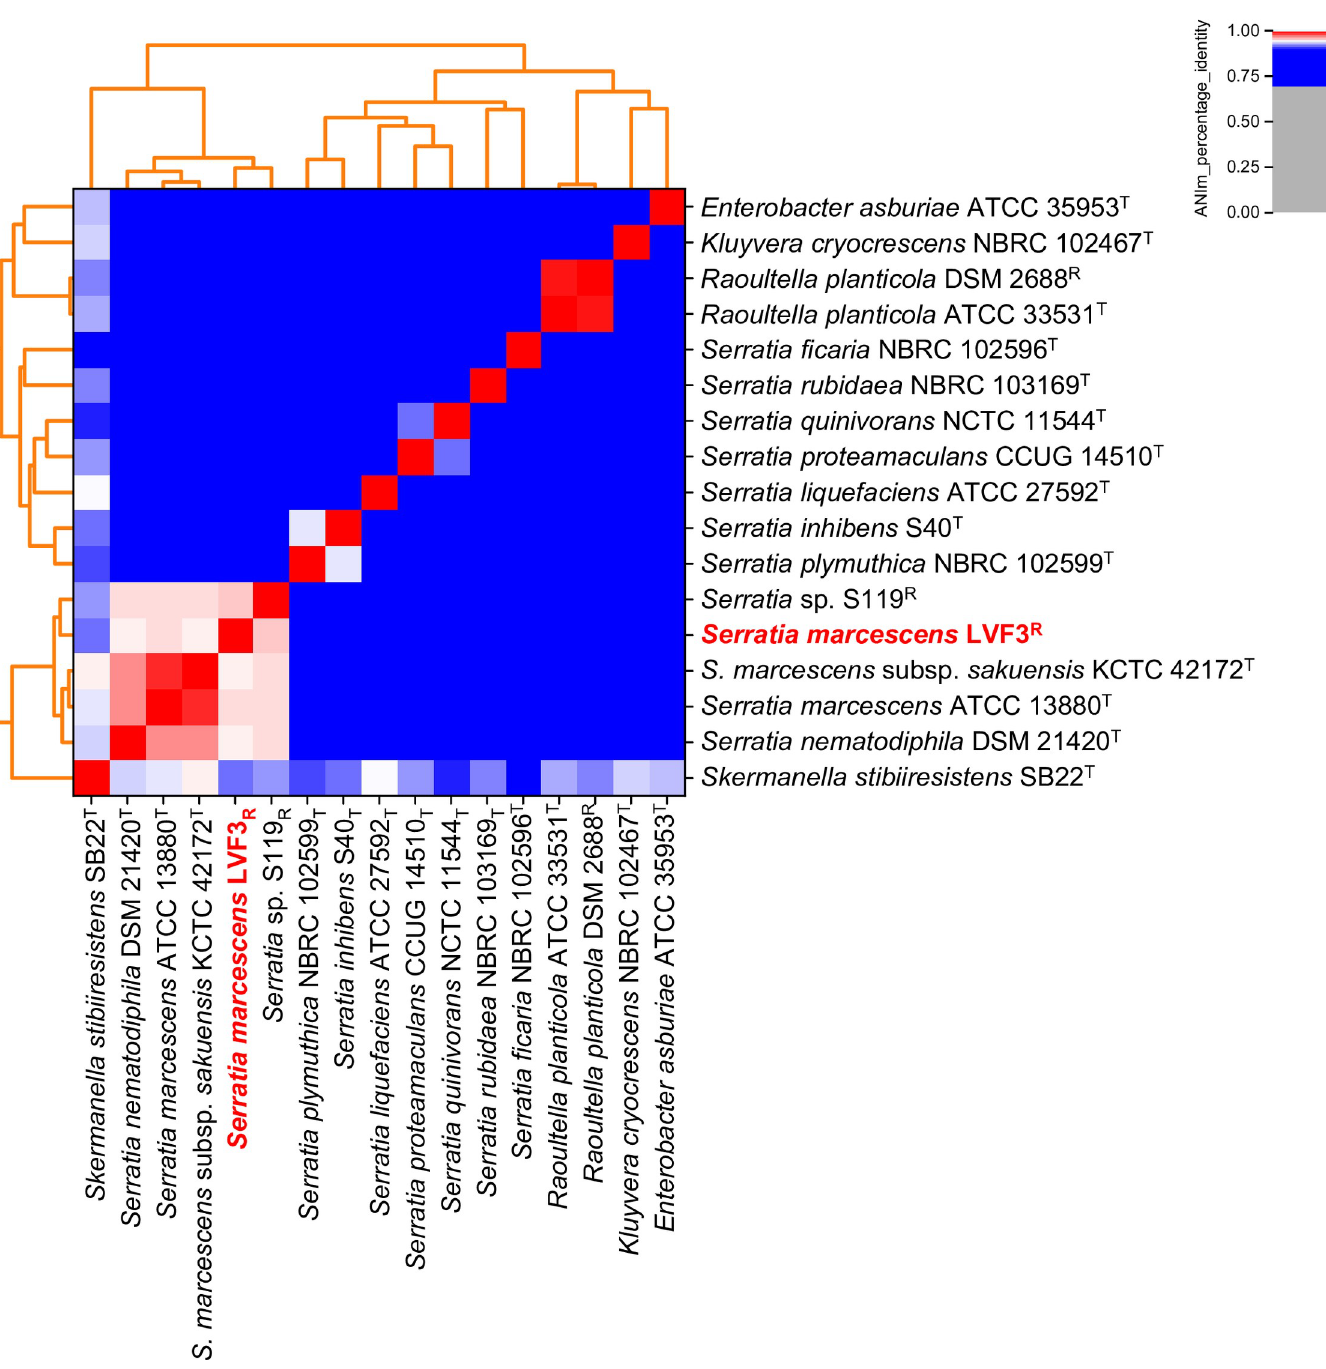
Fig 3. Genome-based phylogenetic analysis of Serratia marcescens LVF3 R . All genomes from available type strains (T) included in the TYGS database [36] and a representative strain (R) from the genus Serratia were examined. Calculations were done with pyani [37,68] using ANIm method with default parameters. LVF3 R is depicted in bold